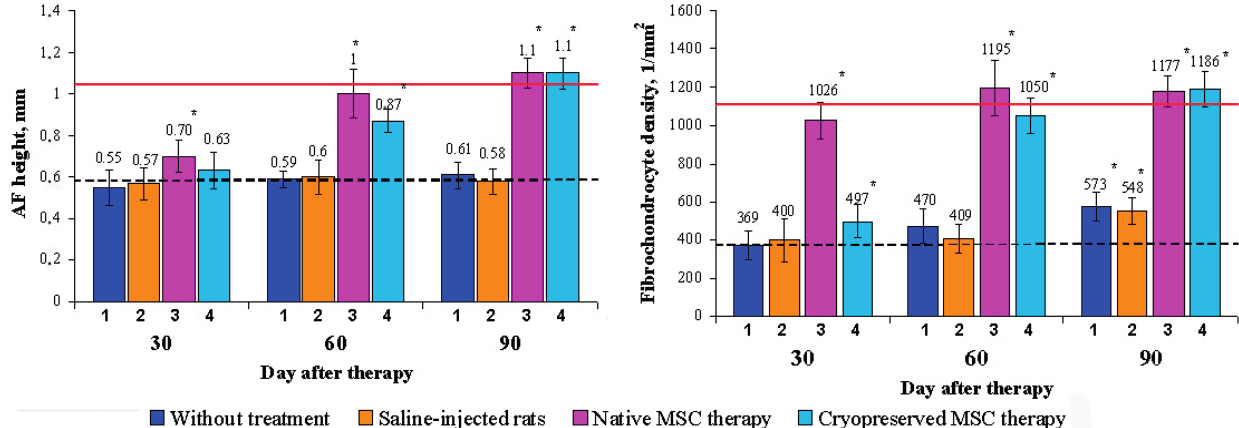
Figure 4. Dynamics of the AF height and fibrochondrocyte density restoration in